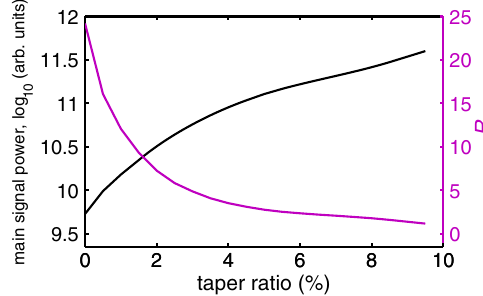
FIG. 6. The main signal (in logarithmic scale) and the ratio R as a function of the taper ratio Δ . The curves in this figure are obtained from the averaged results of 50 independent runs for each taper